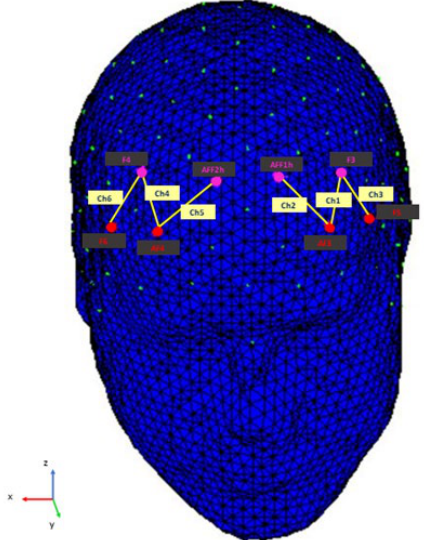
Figure 2. Configuration of fNIRS probes. The sources were placed in AF3–AF4 and F5–F6 (red), while the detectors were placed in AFF1h–AFF2h and F3–F4 (purple). The six resulting channels (yellow) were meant to detect the neural activity from the following areas: Ch1 and Ch4 from the left and right DLPFC (BA 46); Ch2 and Ch5 from the left and right frontopolar area (BA10) and a portion of left and right DLPFC (BA 46); Ch3 and Ch6 from the left and right Broca’s area pars triangularis (BA45). The 3D head render was created with the software nirsLAB (NIRx Medical Technologies LLC), and then the corresponding channels were added.